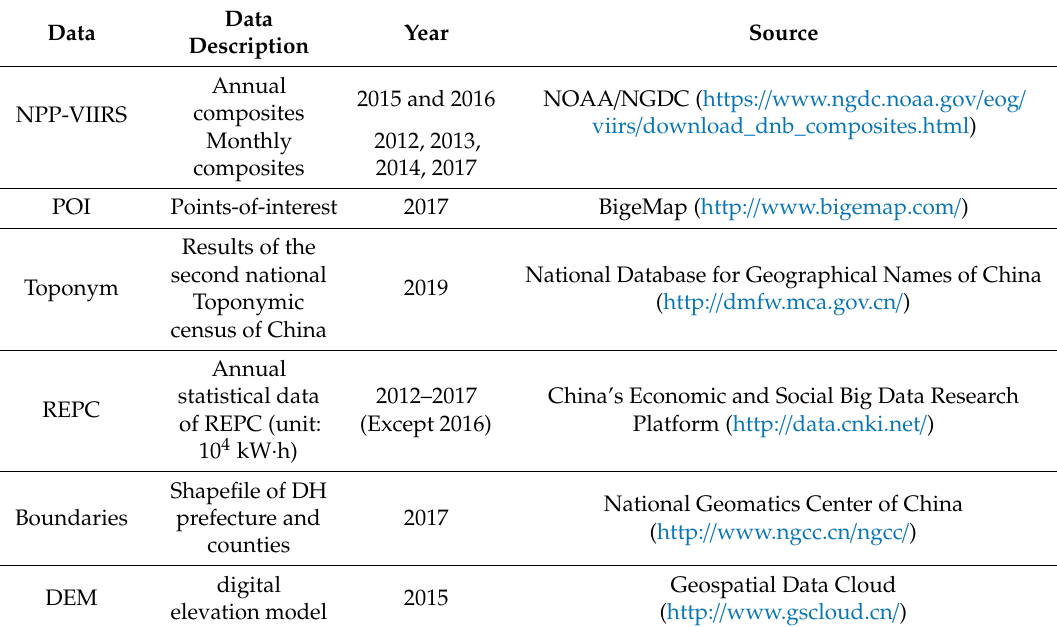
Table 1. Description of the data used in this